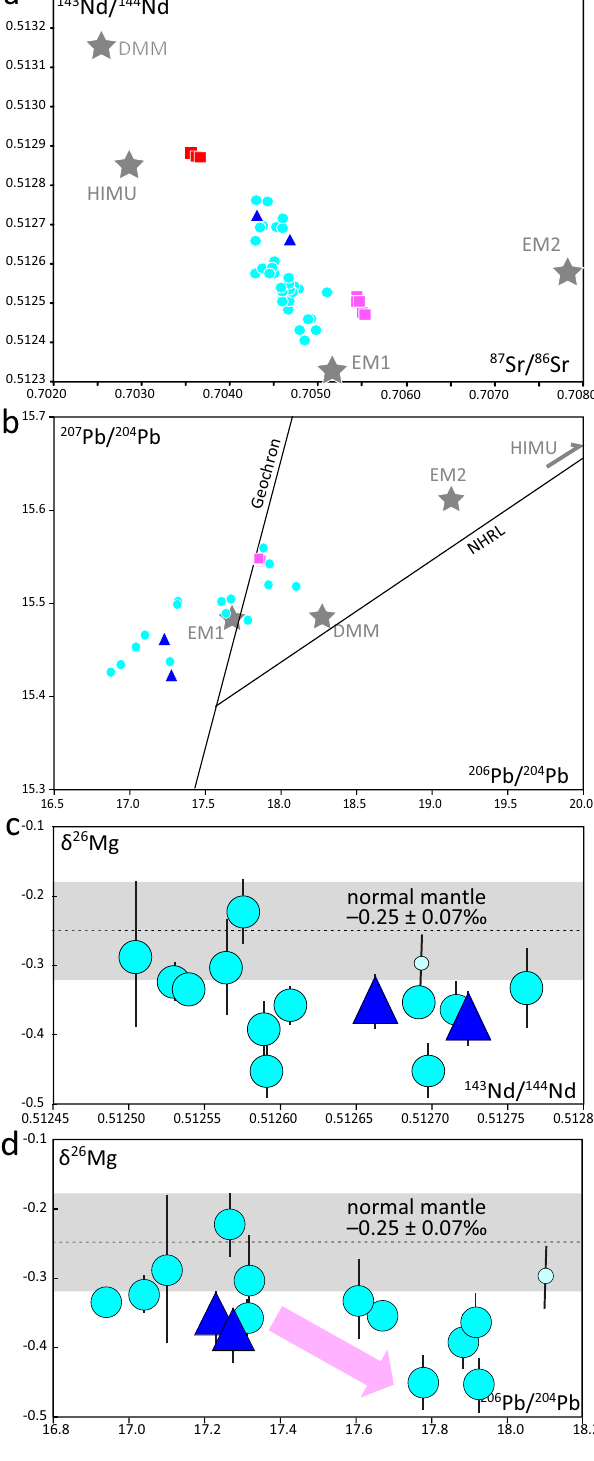
Fig. 7 Isotopic composition of petit-spot basalts. a 87 Sr/ 86 Sr v.s 143 .Nd/ 144 Nd ratios, b 206 Pb/ 204 Pb v.s 207 .Pb/ 204 Pb ratios, c 143 Nd/ 144 Nd ratio v.s. δ 26 Mg, and d 206 Pb/ 204 Pb v.s. δ 26 Mg. Right blue circles show the petit-spot basalt of NW Paci fi c Plate. Blue triangles show the DAP basalt. Red and pink colored squares show the petit-spot basalts off Mariana and Sunda trench, respectively. Mantle endmembers are DMM (Depleted Mid- ocean ridge basalt Mantle), EM-1 and EM-2 (Enriched Mantle 1, 2), and HIMU (High- μ ) 78 – 80 . NHRL shows Northern Hemisphere Reference Line. A small circle in the panels c , d showing high TiO 2 sample is omitted from discussion of the Mg isotopic composition. Error bars in c , d represent 2 standard deviations. The data are available in Supplementary Data